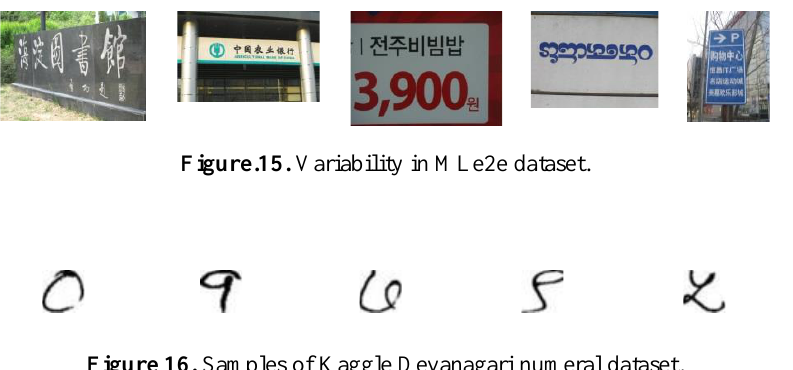
Figure 16. Samples of Kaggle Devanagari numeral dataset.